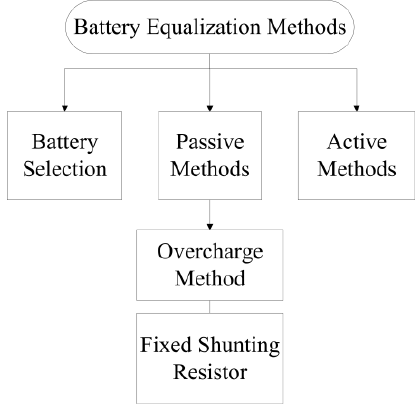
Fig. 1. Classification of the battery equalization